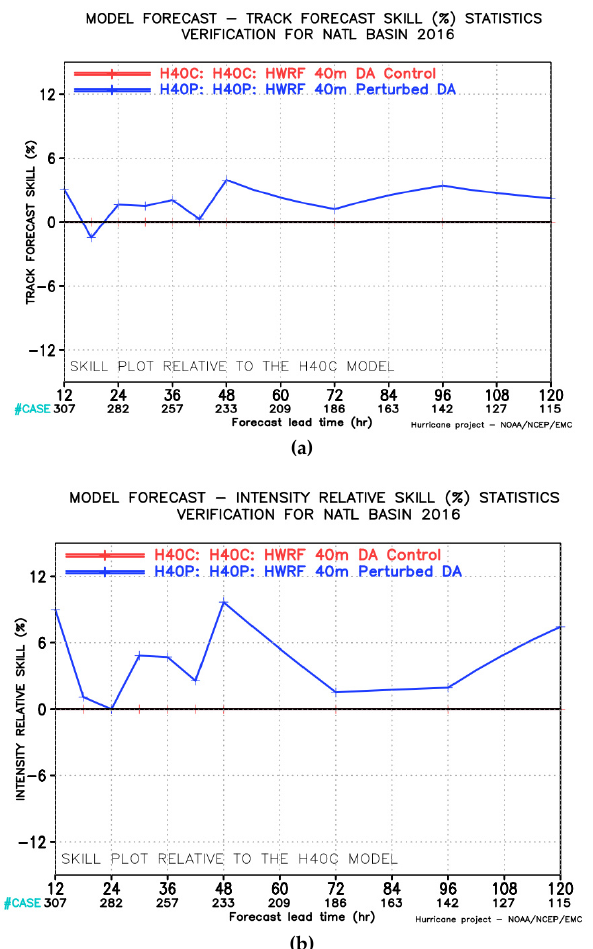
Figure 8. Forecast skill improvements of the experiment with the (H40P) and without the (H40C) stochastic model physics in the self-cycled DA, for the track ( a ) and intensity ( b ) forecasts. All 2016 North Atlantic (NATL) storms are included.